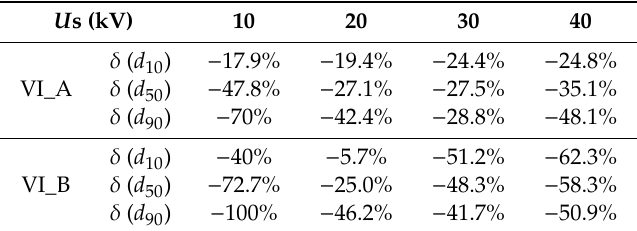
Table 4. Relative variations in the 10%, 50% and 90% prestrike gaps.